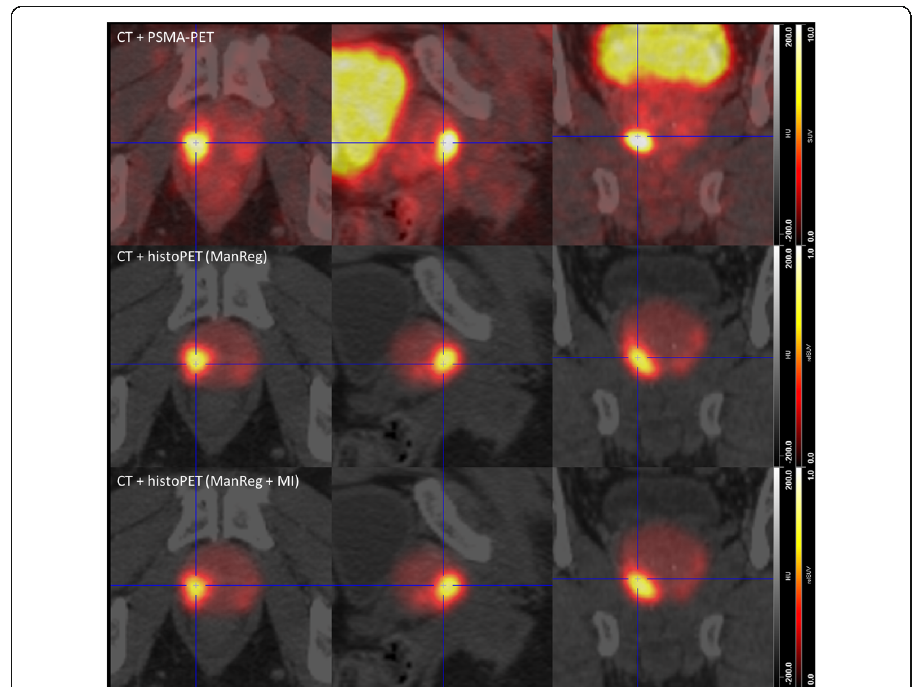
Fig. 4 Visual comparison of PSMA-PET/CT and histoPET models according to ManReg and ManRegMI